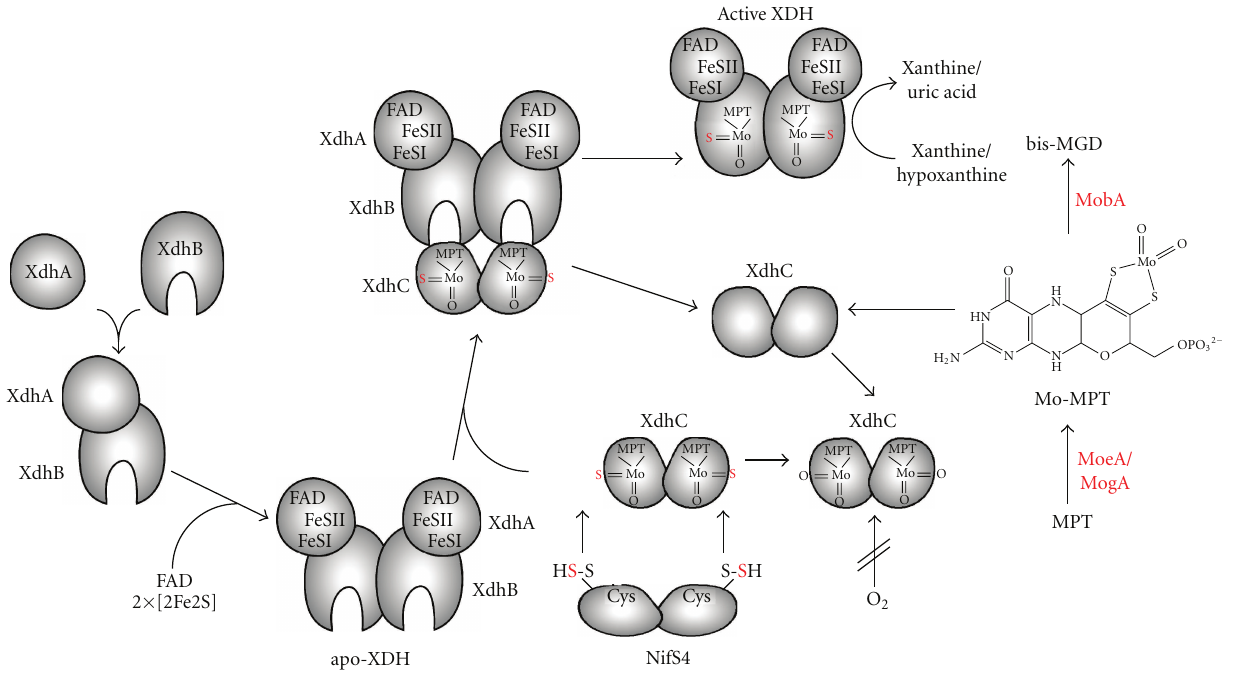
Figure 6: Model for the role of XdhC in the assembly of R. capsulatus XDH. The assembly of R. capsulatus XDH involves the synthesis of the XdhA and XdhB subunits, the dimerization of both subunits, the insertion of FeSI, FeSII, and FAD into the XdhA subunit, dimerization of two ( αβ ) dimers via the XdhB subunit to form the Moco-free apo-XDH, and finally, insertion of sulfurated Moco into XdhC. Mo-MPT is produced by molybdenum insertion into MPT catalyzed by MogA and MoeA and can further be converted to bis-MGD by the MobA protein. It is suggested that MoeA/MogA/MobA and XdhC form a complex in the cell. XdhC binds Mo-MPT, and the equatorial Mo = S is inserted into Moco before its incorporation into XDH by the sulfurtransferase function of the NifS4 protein. XdhC protects Moco from oxidation and interacts with XDH for Moco